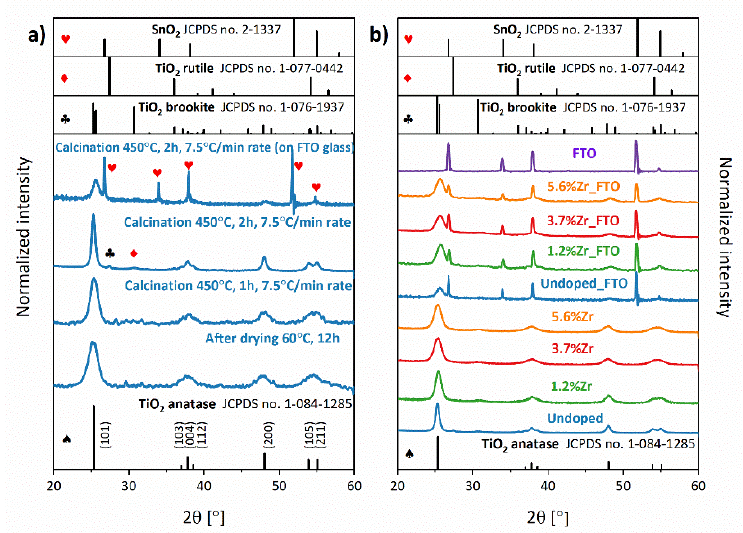
Figure 4. XRD patterns of bare TiO 2 annealed at different conditions ( a ), and Zr 4+ -doped TiO 2 in the form of nanopowders and as working electrodes (on FTO substrate) ( b ).